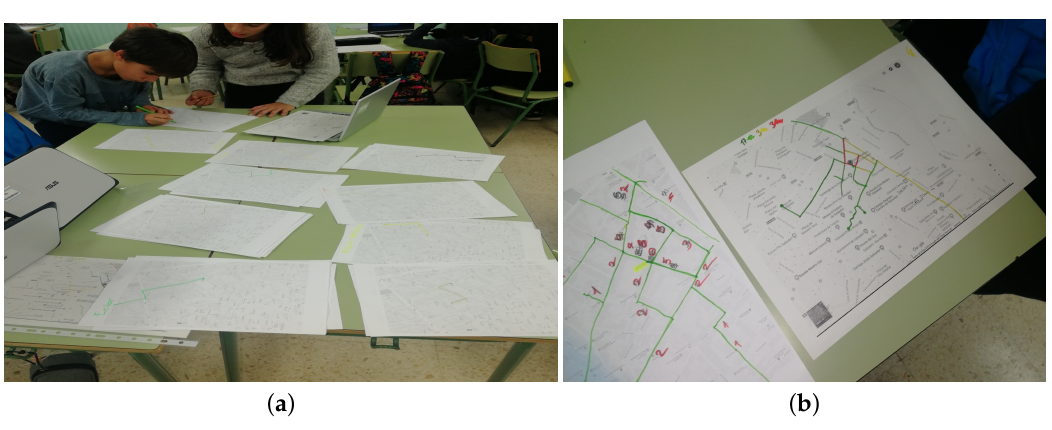
Figure 7. ( a ) Organizing the collected routes, ( b ) representing them on a single map.